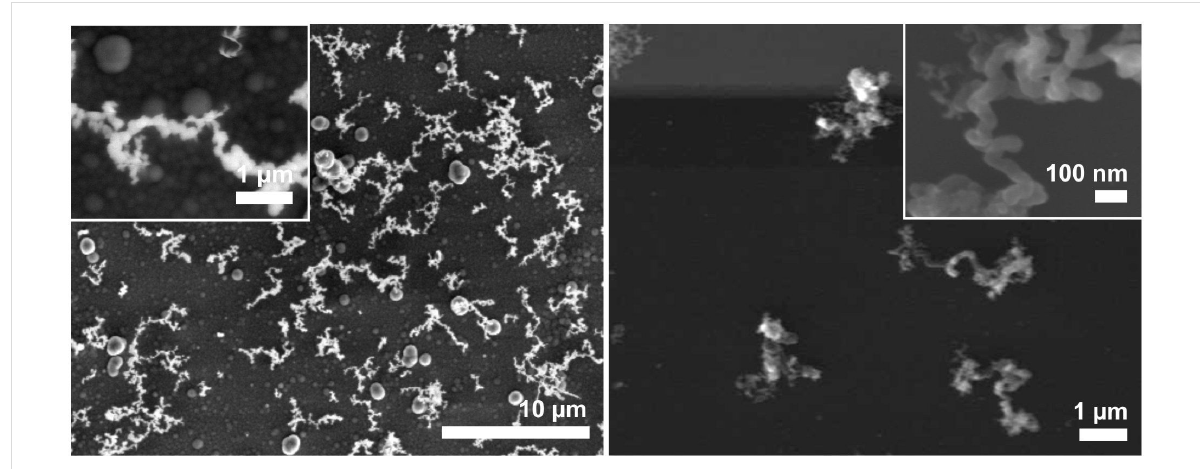
Figure 9: SEM image of NWs grown from nanoparticles at 650 °C without prior treatment (left) and at 375 °C after H 2 -plasma treatment for 40 min (right). Observe that at the lower temperature no round Si particles could be found on the sample.